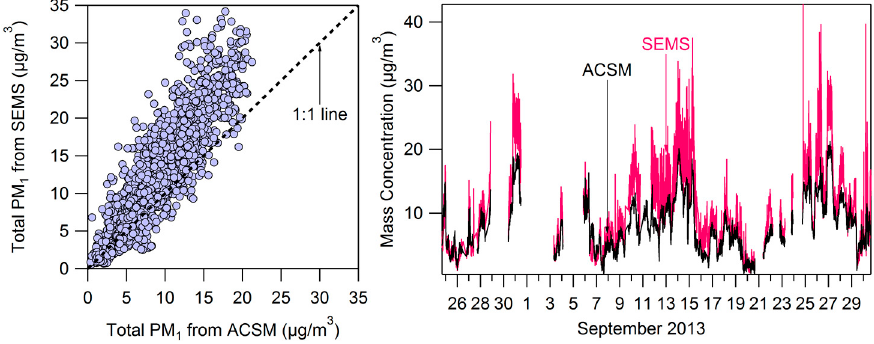
Figure A1. Comparison of PM 1 mass measured by the SEMS and ACSM throughout the campaign.